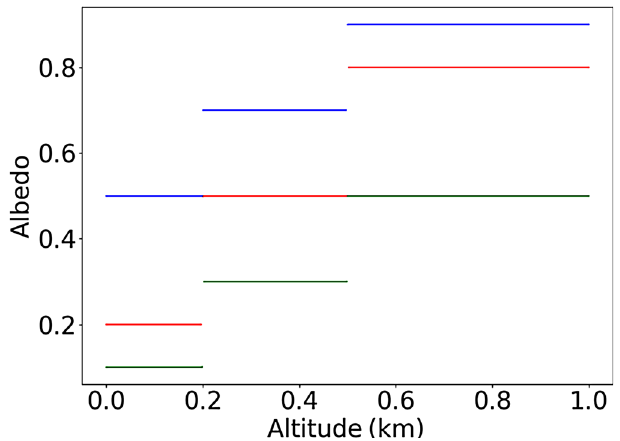
Fig. 3. Albedo pro fi les with altitude used throughout this study. The values increase with the altitude to match sea, forest, and snow areas on the real terrain. The green and blue pro fi les have low and high albedo, respectively, with small contrast between sea and snow. The red pro fi le has high contrast, with dark sea and bright snow.